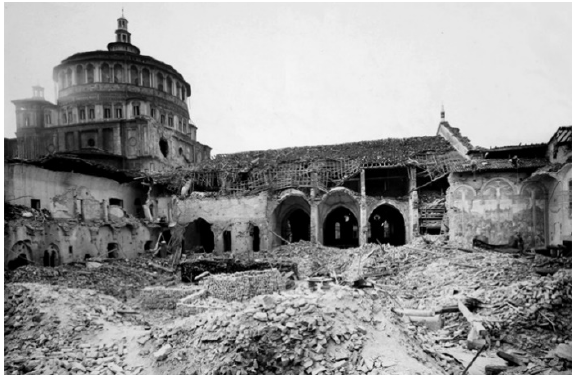
Figure 3. The devastation of Santa Maria delle Grazie after the 1943 bombs seen from the Last Supper wall.